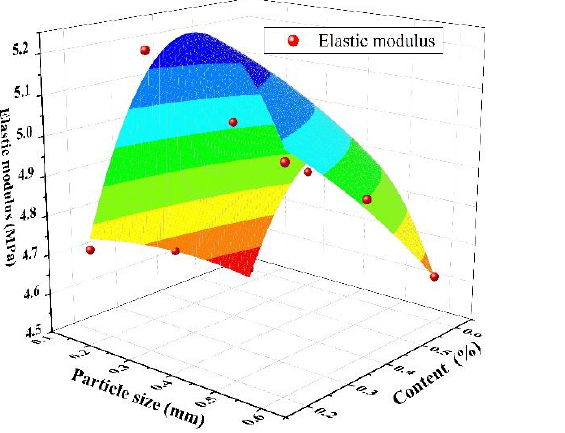
( b ) Figure 7. Elastic modulus of concrete under two water–cement ratios: ( a ) different SAP content; ( b ) different SAP particle size.